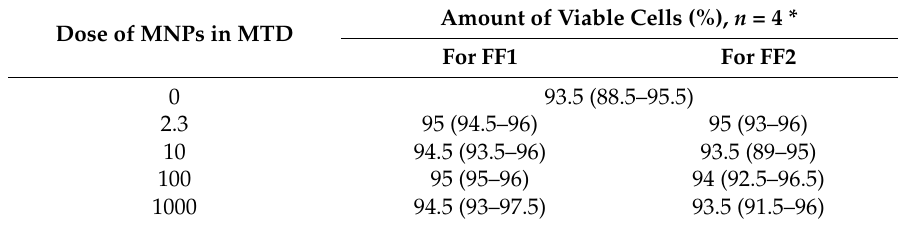
Table 2. Percentage of viable HBMLs (according to ISO 10993-5 test with 0.4% trypan blue) after